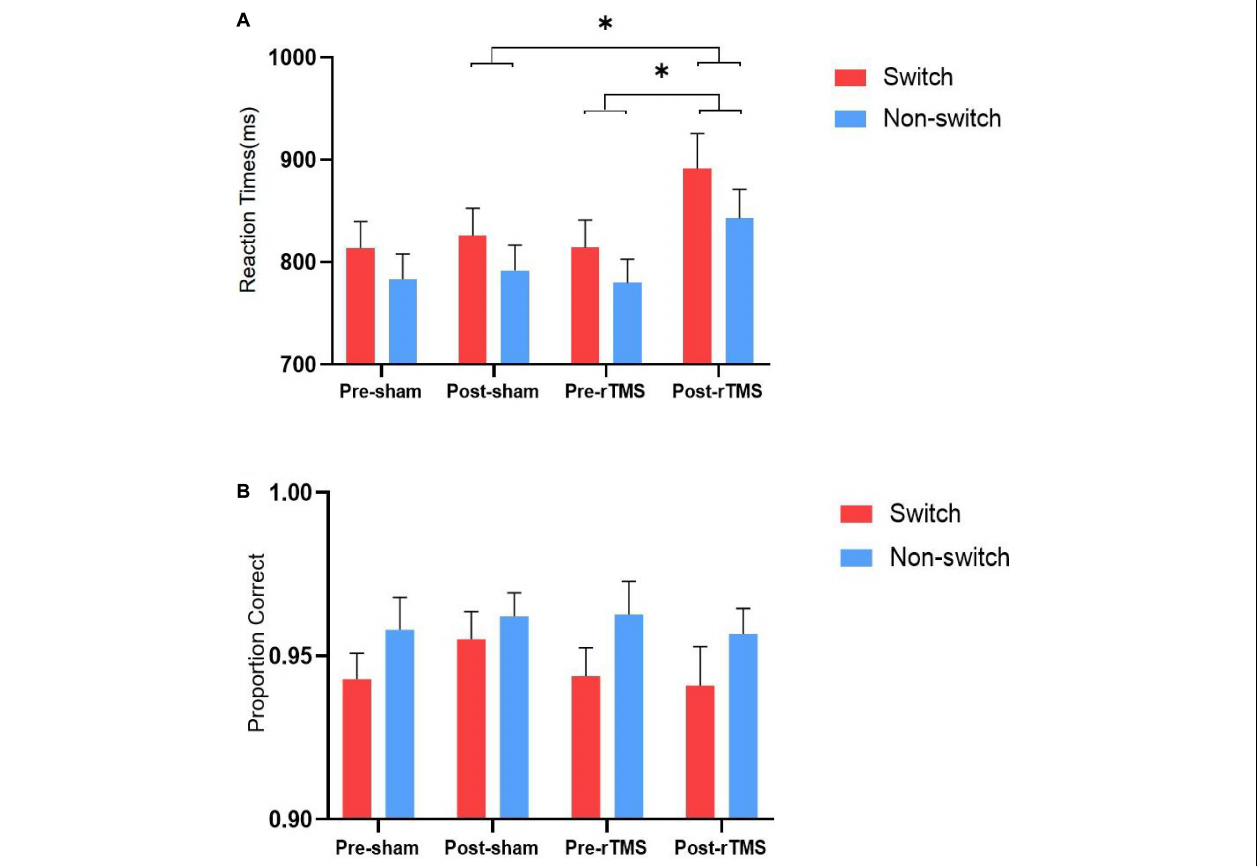
FIGURE 1 | Reaction times (A) and accuracy rates (B) on switch and non-switch conditions for different stimulation conditions. ∗ Significant difference between stimulation conditions, p < 0.05. Error bars represent